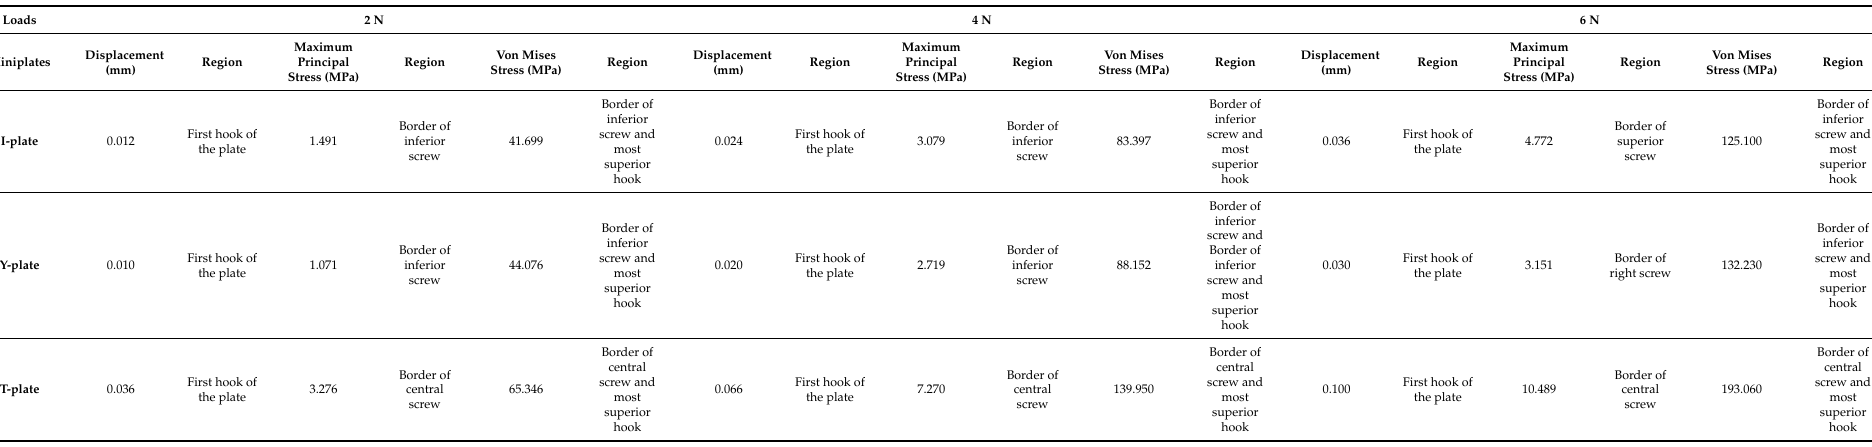
Table 3. Displacement, maximum principal stress, and von Mises stress were obtained for three types of miniplates (I, Y, and T) submitted to loads of 2, 4, and 6